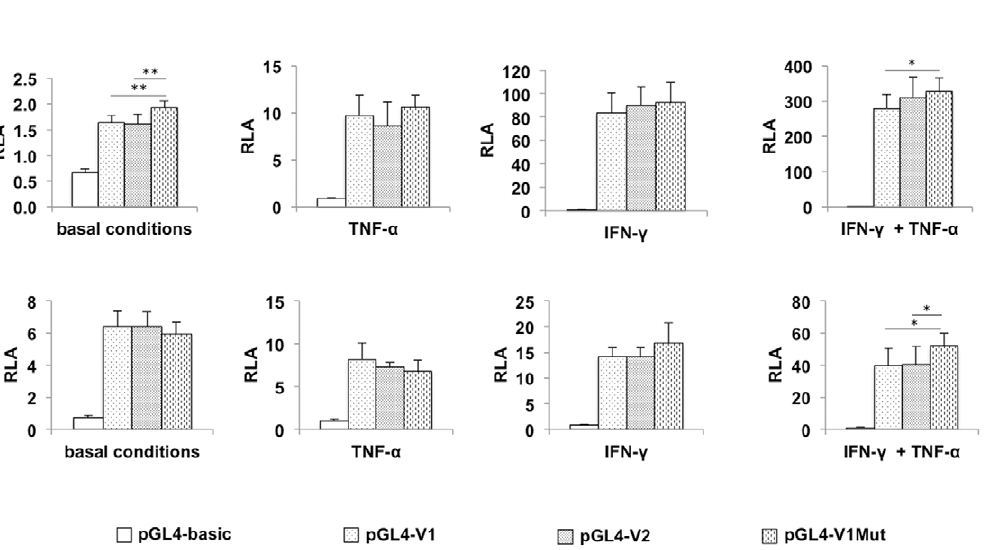
Figure 2. Functional analyses of *V1 , *V2 and *V1Mut alleles of the IDO1 promoter in HeLa cells. The four promoter constructs (pGL4-V1, pGL4-V2, pGL4-V1Mut and the promoterless pGL4-basic vector) and a renilla control vector (pGL4.74), without (A) or with (B) the VP16-TCF expression vector, were transiently transfected into HeLa cells. The luciferase activities were measured in basal conditions, or after stimulation by IFN- c (10 ng/ mL), TNF- a (5 ng /mL), or combined IFN- c and TNF- a (10 ng/mL and 5 ng/mL, respectively). Results, expressed as relative firefly luciferase units normalized to renilla luciferase, are the mean 6 SEM of triplicates from three independent experiments and are presented on a linear scale. Asterisks indicate statistical significance of * p , 0.05 and ** p , 0.001.